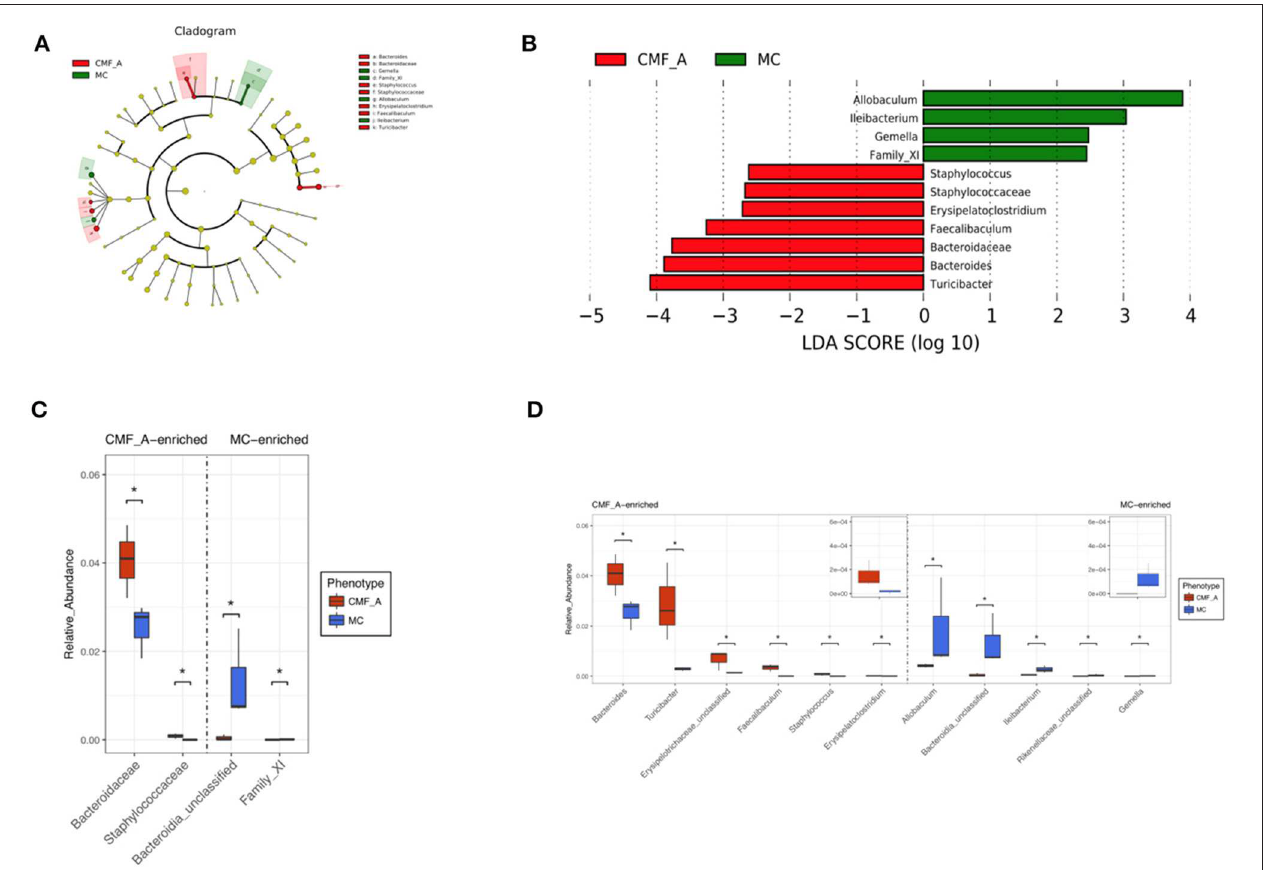
FIGURE 6 | Comparison of gut microbiota between CMF-A group and MC group. Cladogram of linear discriminant analysis (LDA) coupled with effective size measurement showing differentially abundant genera (A) . Histogram of LDA scores for differentially abundant genera (B) . qPCR identified the difference in CMF-A group and MC group of mice and t -test for significance testing at family level (C) and genus level (D) . Superscript letters indicate statistical differences (* P <